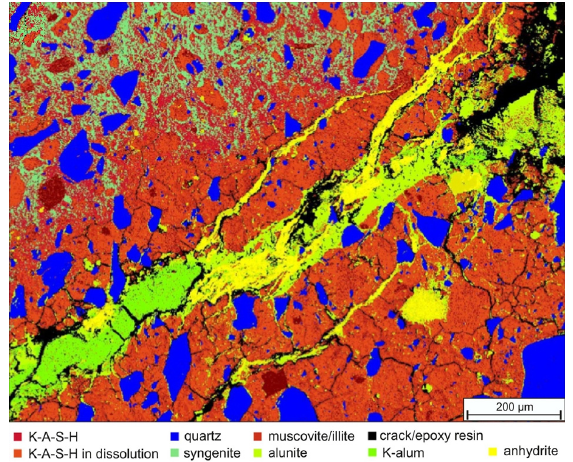
Figure 5. High ‐ resolution phase distribution (obtained through phase calculations with XMapTool based on quantitative EPMA mappings) of a region in the transition zone between the corroded layer and the intact core of a metakaolin ‐ based AAM after exposure to sulfuric acid (pH = 2) for 35 days at room temperature. The intact core of the specimen is located towards the top left of the image; the outer, exposed surfaces of the specimen are located towards the right and the bottom of the image. Several different sulfate phases are located in cracks. [Adapted from C. Grengg et al ., Cem Concr Res (2021) 142: 106373 [22], published under a Creative Commons license: https://creativecommons.org/licenses/by/4.0/; the label ‘A’ has been removed from the top left corner of the original image and the image